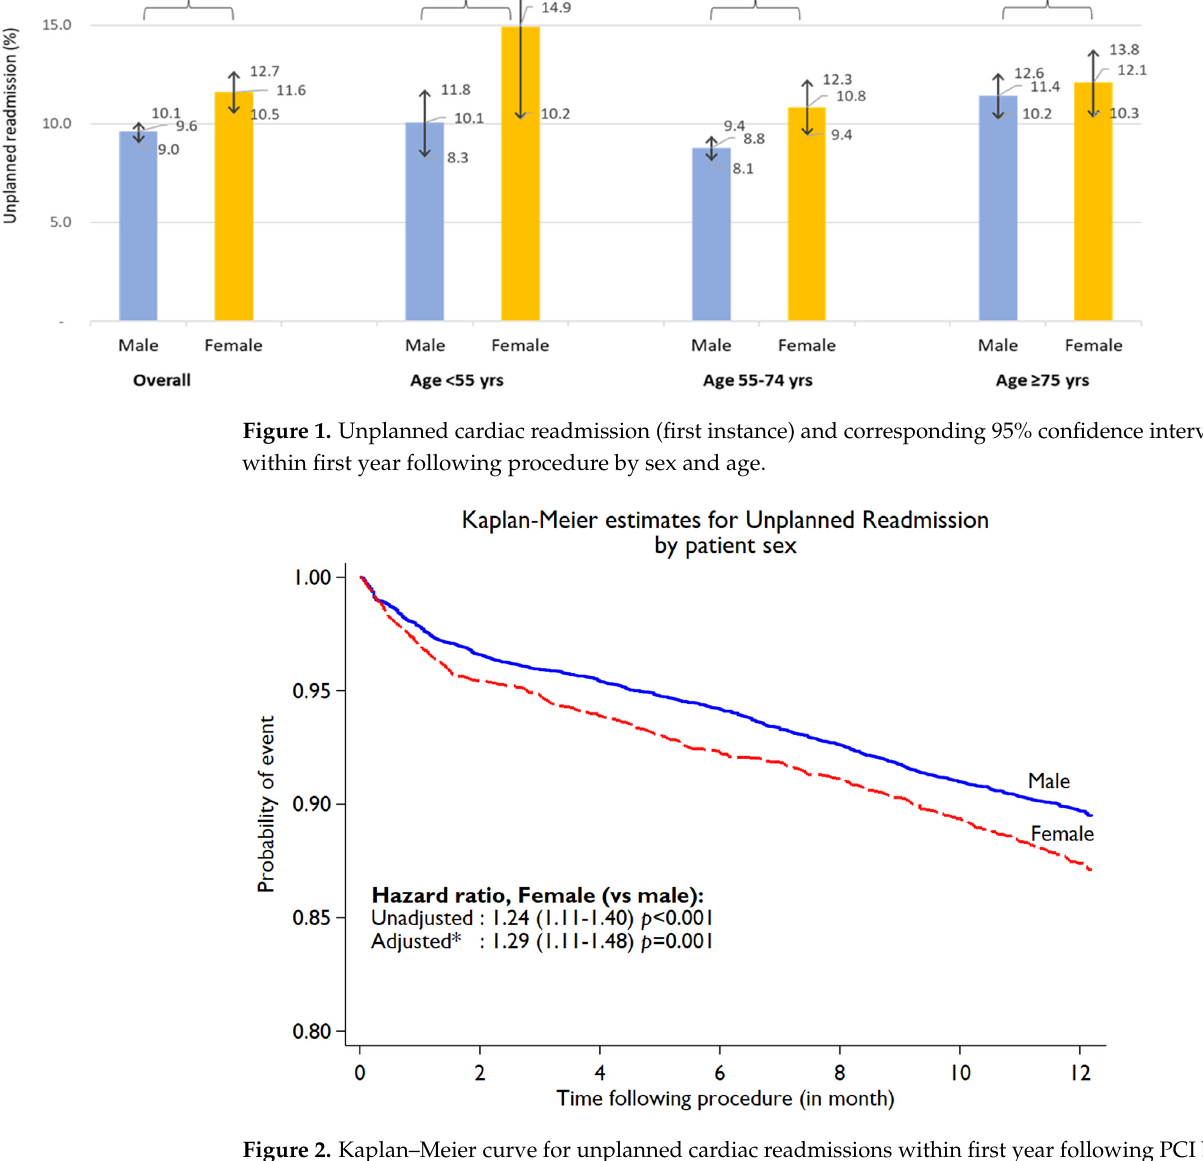
Figure 3. Association of unplanned cardiac readmissions in first year with death in year 2 among the study cohort. * Adjusted for age, diabetes, BMI, hypertension, hypercholesterolemia, previous history of MI, PVD, or CABG, smoking, renal dysfunction, pci presentation, and multivessel disease.